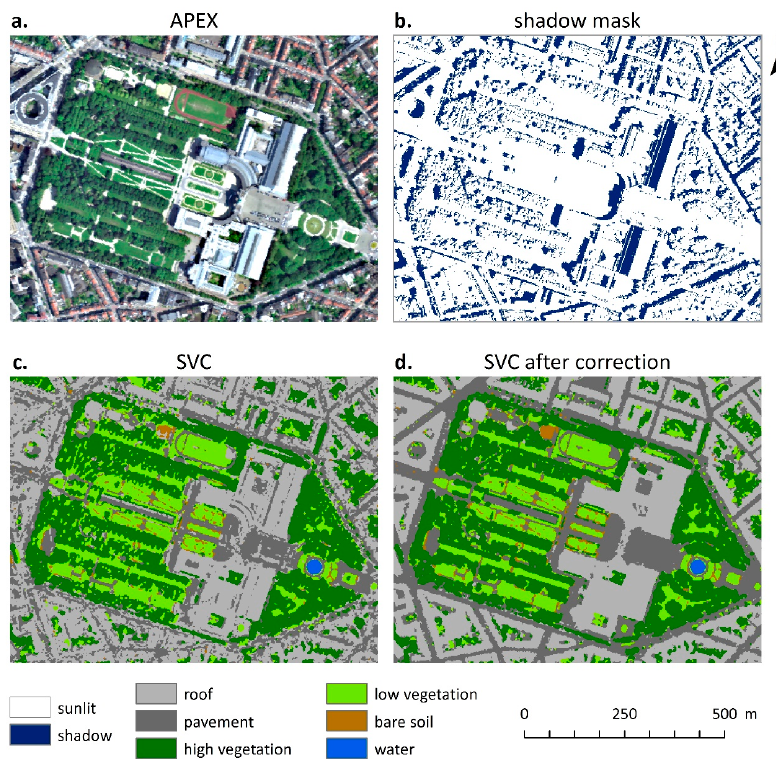
Figure 9. The RGB APEX image ( a ) and the hybrid shadow mask ( b ) have been included in this figure as visual reference. Illustration of level 1 results of Support Vector Classification ( c ) and LiDAR post-classification correction ( d ) for a larger subset covering the Cinquantenaire Park and surroundings.